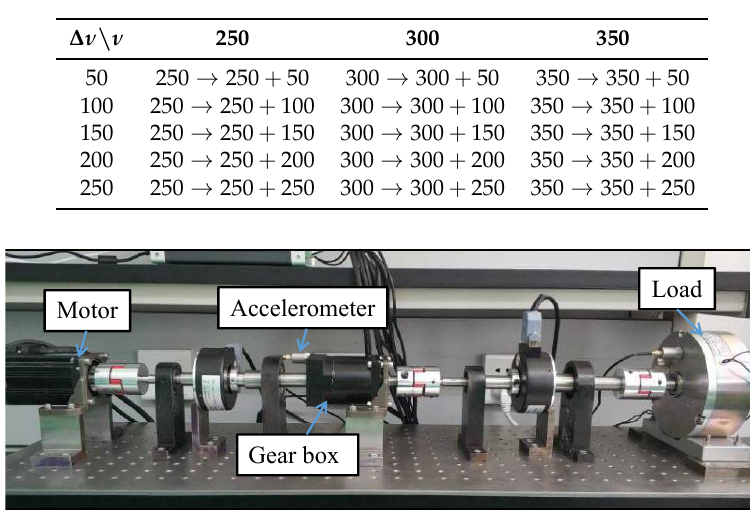
Figure 5. Experimental setup.